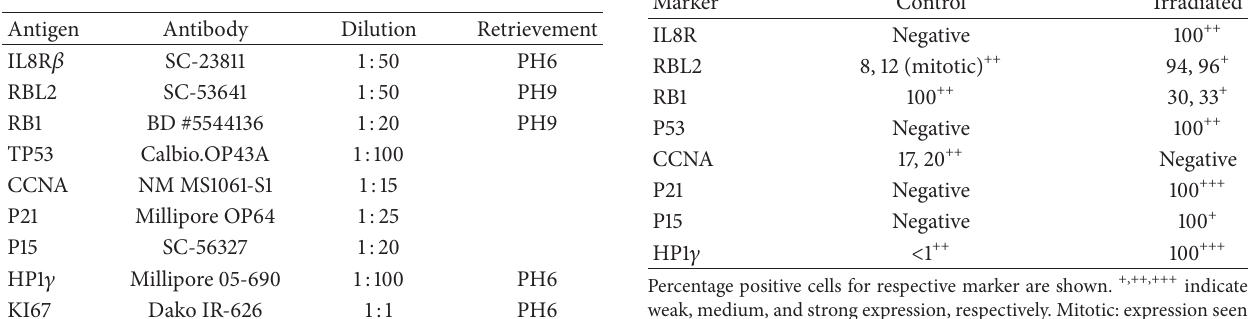
Table 2: Antibodies used for immunohistochemistry and immunofluorescence. Antigen Antibody Dilution Retrievement